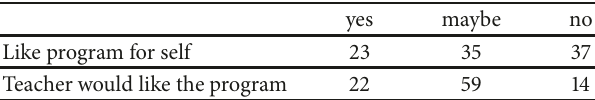
Table 3: Assessment of whether teacher or self would like the nongame version.